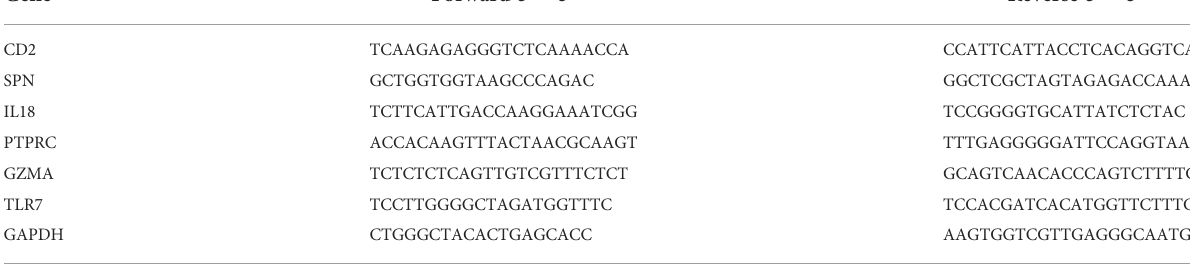
TABLE 1 RT-qPCR primer